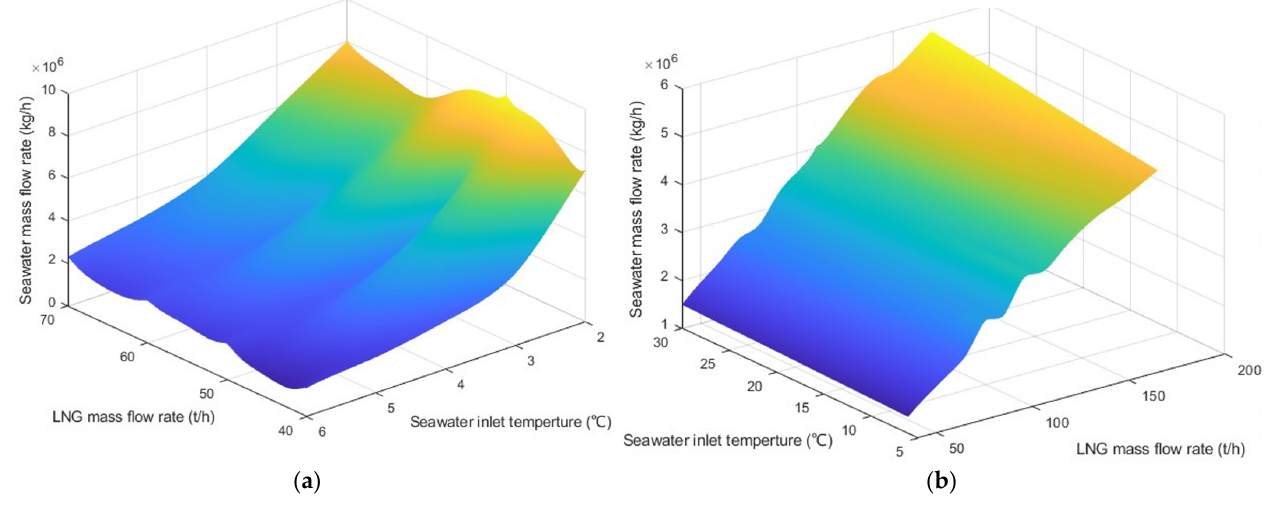
Figure 17. Relationship between the seawater flow rate, seawater inlet temperature, and LNG flow: ( a ) when the seawater inlet temperature was lower than 6 °C; ( b ) when seawater inlet temperature was higher than 6 °C.